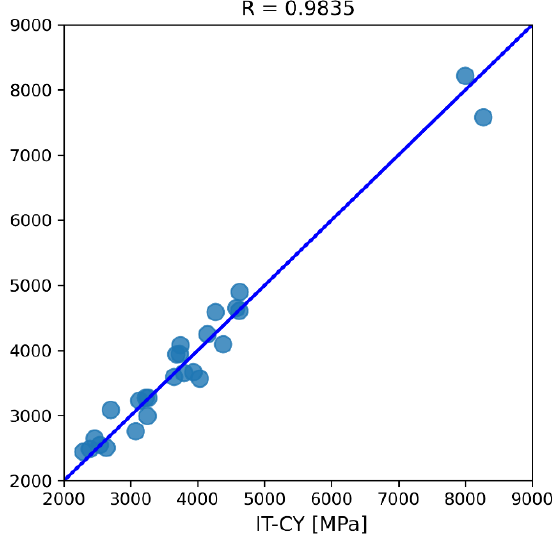
Figure 5. CatBoost model regression plots for AV ( up ), and IT-CY ( down ) data.